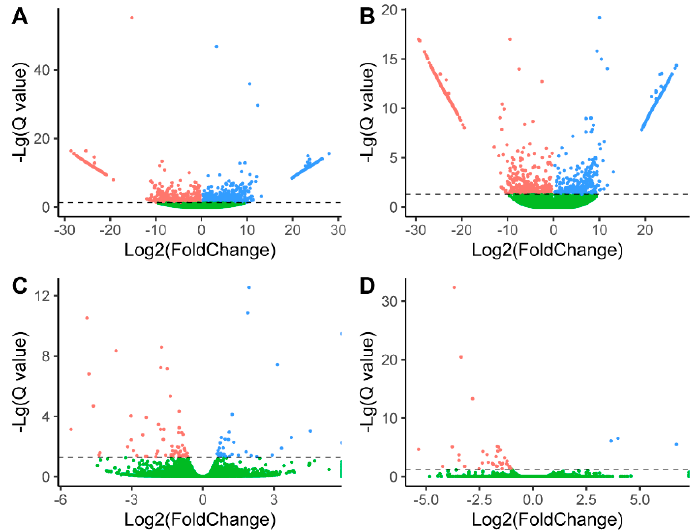
Figure 3. Volcano plots of differentially expressed genes in the ovaries of Yunshang black goats ( A , B ) and Small Tail Han sheep ( C , D ). ( A , C ) indicate luteal phases, and ( B , D ) denote follicular phases. Compared with the low-yield groups, points in red, blue and green are the down-regulated, up-regulated, and non-differentially expressed genes in high-yield groups, respectively. The dashed lines are thresholds of 1.30 ( − lg(0.05)).